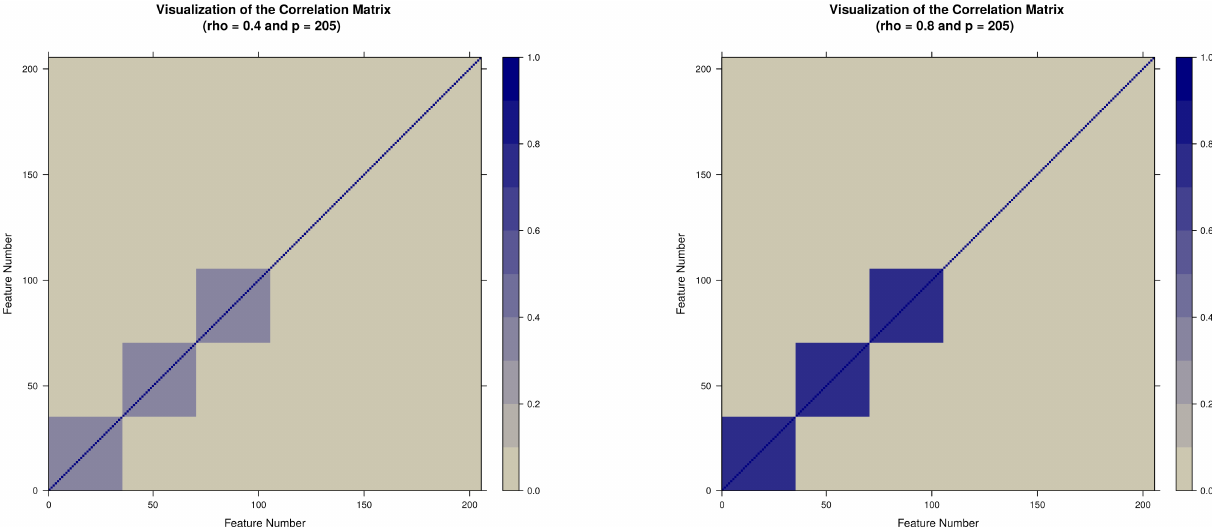
Fig 1. Visualization of power (left column) and Type I error (right column) estimates comparison between p = 205 (solid lines) and p = 2050 (dashed line) features for ρ = 0.4 and sample sizes n = 10 (top row), n = 50 (middle row), and n = 100 (bottom row). The value of the penalty split parameter α is plotted on the x -axis. Type I error and power estimates are plotted on y -axis for the values of α in the range of [0; 1] with 0.1 increments. In the left column power estimates are provided based on the four different features for each of the effect sizes ( Δ 1 = 0.2 is the red line, Δ 2 = 0.5 is the blue line, and Δ 3 = 0.8 is the green line). In the right column Type I error estimates are provided (beige lines) based on the random noise features together with a 0.05 threshold plotted as a purple dashed line. The vertical dashed line in the right column plots corresponds to penalty split value α = 0.5. The value of α = 0 corresponds to ridge regression and α = 1 corresponds to